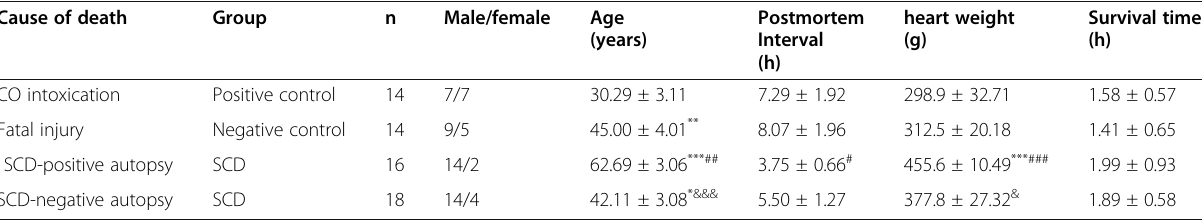
Table 1 Basic information regarding the human fatal cases Cause of death Group n CO intoxication SCD-positive autopsy SCD-negative